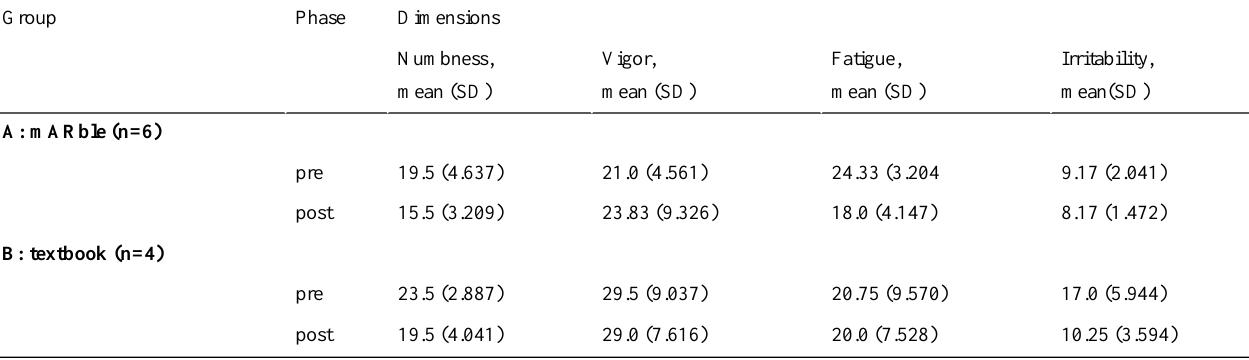
Table 2. Aggregated values for numbness, vigor, fatigue, and irritability. DimensionsPhaseGroup